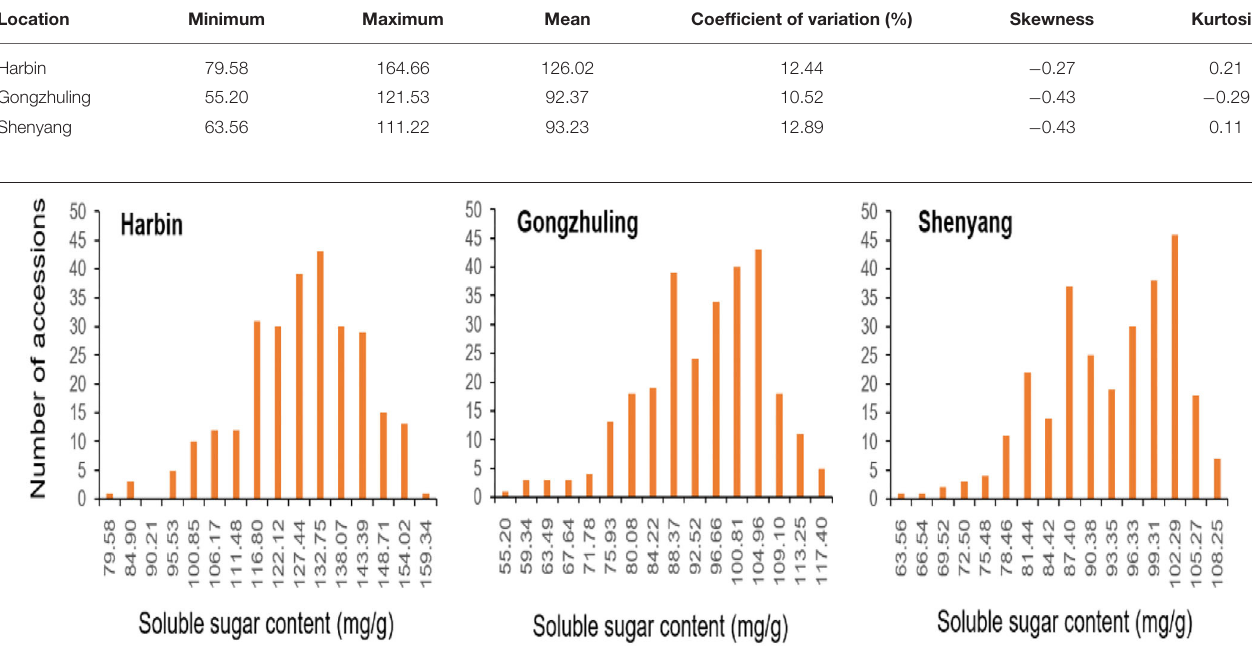
FIGURE 1 | Variation of total soluble sugar content among 278 accessions in three environments (“Harbin,” “Gongzhuling,” and “Shenyang”).